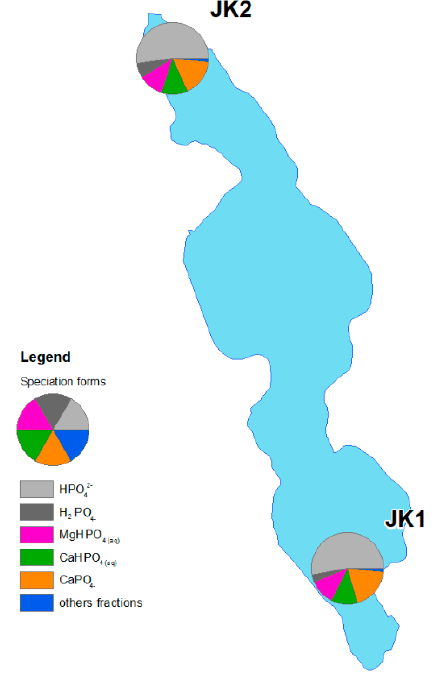
Figure 7. Average content of speciation fractions during the study period. In addition, PCA was used to identify the environmental factors (physicochemical indicators) influencing the content of speciation forms. The aim of PCA was to identify factors that determine the content of speciation forms in bottom sediments. PCA identified two significant factors, factor 1 (first principal components) and factor 2 (second principal components), whose eigenvalues were higher than 1. This analysis for point JK1 explained 79.88% of the variability in the data. The first factor, which accounted for 50.97% of data variability, was mainly related to the fractions of positively correlated indices such as CaHPO 4 (aq) and CaPO 4 − . These indicators were negatively correlated with the HPO 42 − form. This indicates that a decrease in the form of HPO 42 − is observed with the growth in the calcium speciation form. The above-mentioned factors were mainly related to indicators such as Ca 2+ , pH, BOD 5 , and oxygen. The second factor, accounting for 28.91% of the variability in the data, was associated with the form H 2 PO 4 − and the other speciation forms. This factor was connected with indicators such as total P, P-PO 4 , Mg 2+ , SO 42 − , and N-NH 4 . For the second point, JK2, this analysis explained 78.21% of the variability in the data. The first factor, which accounted for 47.31% of data variability, was mainly related to the fractions of positively correlated indices such as CaHPO 4 (aq) and CaPO 4 − . These indicators were negatively correlated with the HPO 42 − form (as for point JK1). These factors were mainly related to Ca concentrations. In addition, the second factor, accounting for 30.90% of the variability in the data, was associated with the form HPO 42 − . These factors were connected with indicators such as Mg 2+ , SO 42 − , and N-NH 4 (as for point JK1) and with EC (Figure